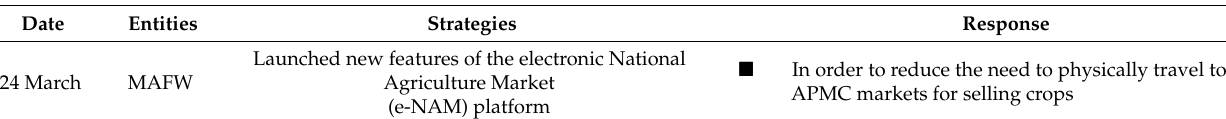
Table 2. India’s strategies and response towards for sustainable food processing industry during